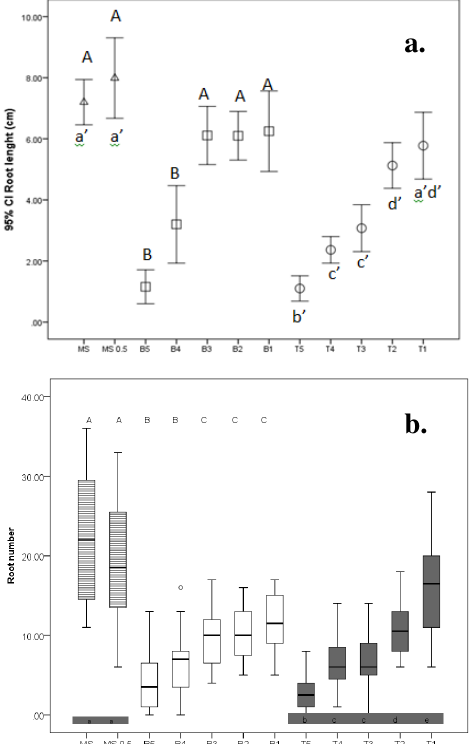
Fig. 3. The length of the tap-roots ( a ); N = 20, N MS, MS1/2, B5-3, T1- 5 =15, N =10; One Way ANOVA, post-hoc comparison: Games- B2 B1 Howell test, N = 20, N =15, N =10; Significant MS, MS1/2, B5-3, T1- 5 B2 B1 differences are represented by different characters, p<0.05. Tap-root numbers ( b ); N =20, N =15, N =10; Kruskall- MS, MS1/2, B5-3, T1-5 B2 B1 Wallis, post-hoc comparison: Mann-Whitney U test, N MS, MS1/2, B5-3, = 20, N =15, N =10; Significant differences are represented by T1- 5 B2 B1 different characters, p<0.05